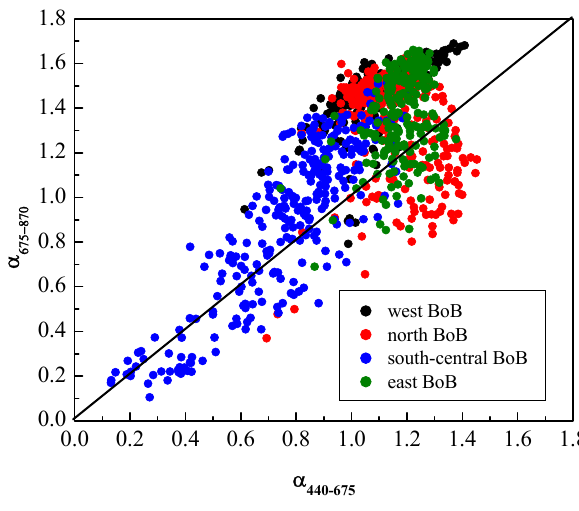
Fig. 11. Correlation between α 440 − 675 with α 675 − 870 over the four BoB